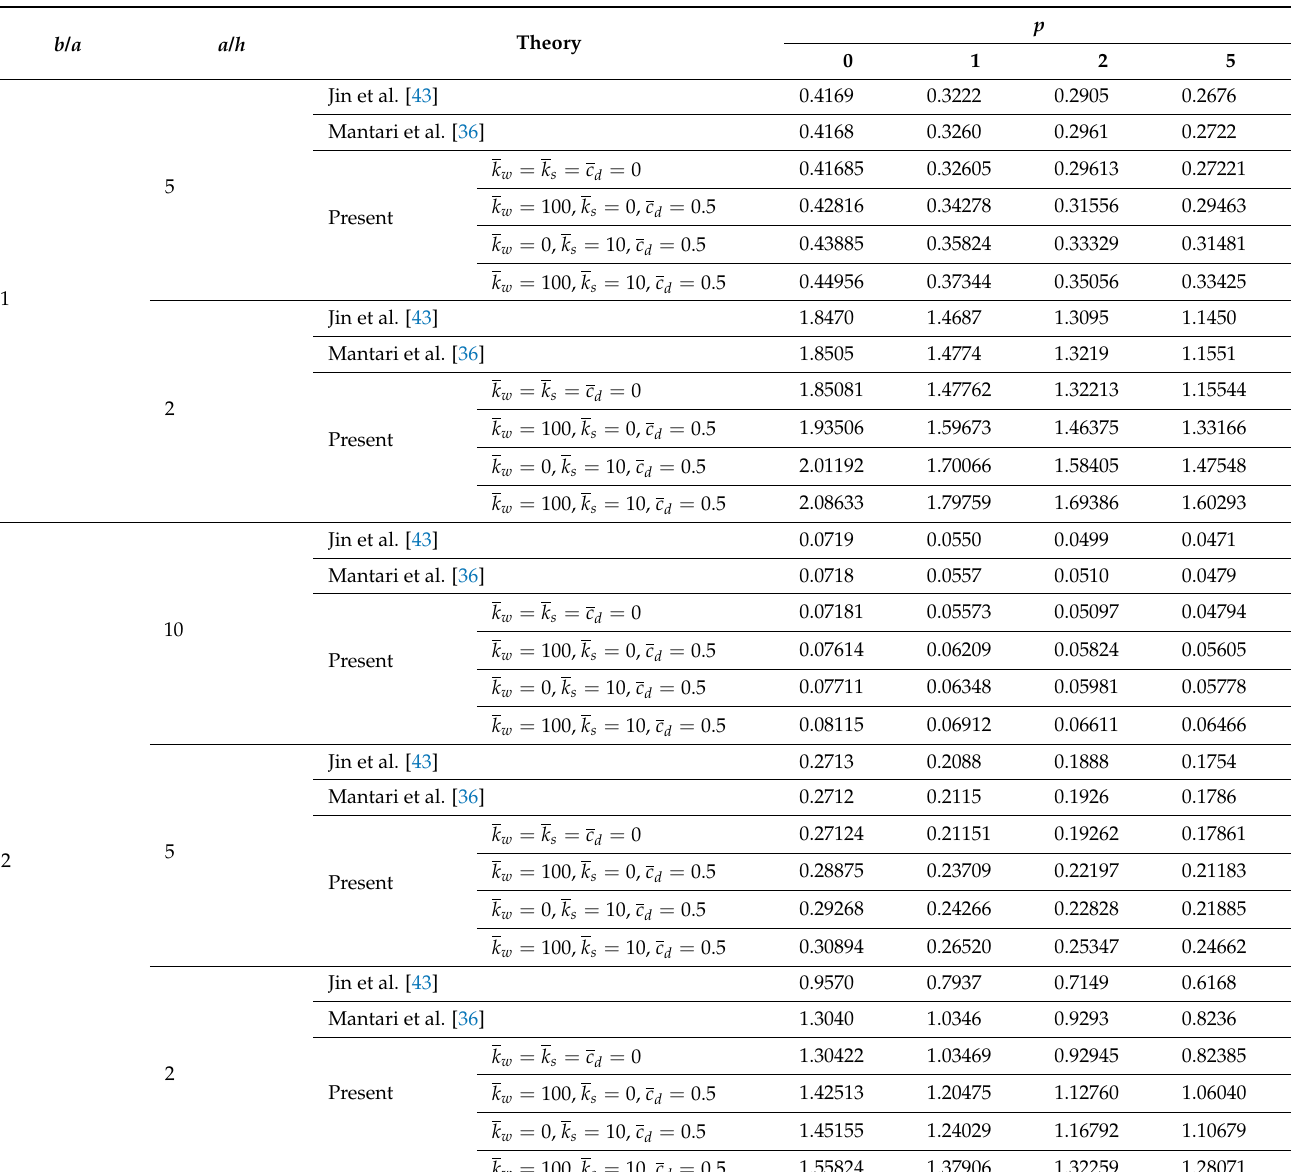
(cid:1)(cid:112) (cid:0) ω a 2 / h ρ m / E m for Aluminum- (cid:1)(cid:112) (cid:0) ω a 2 / h ρ c / E c .